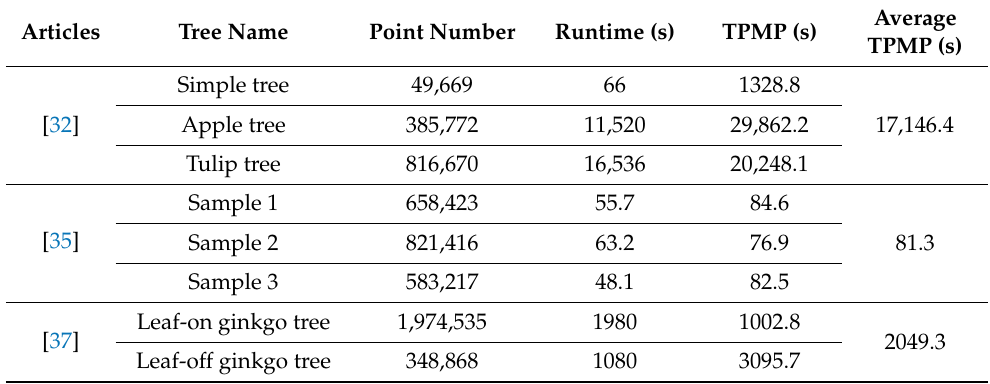
Table 3. The information of Bucksch’s article, He’s article, and Ai’s article.